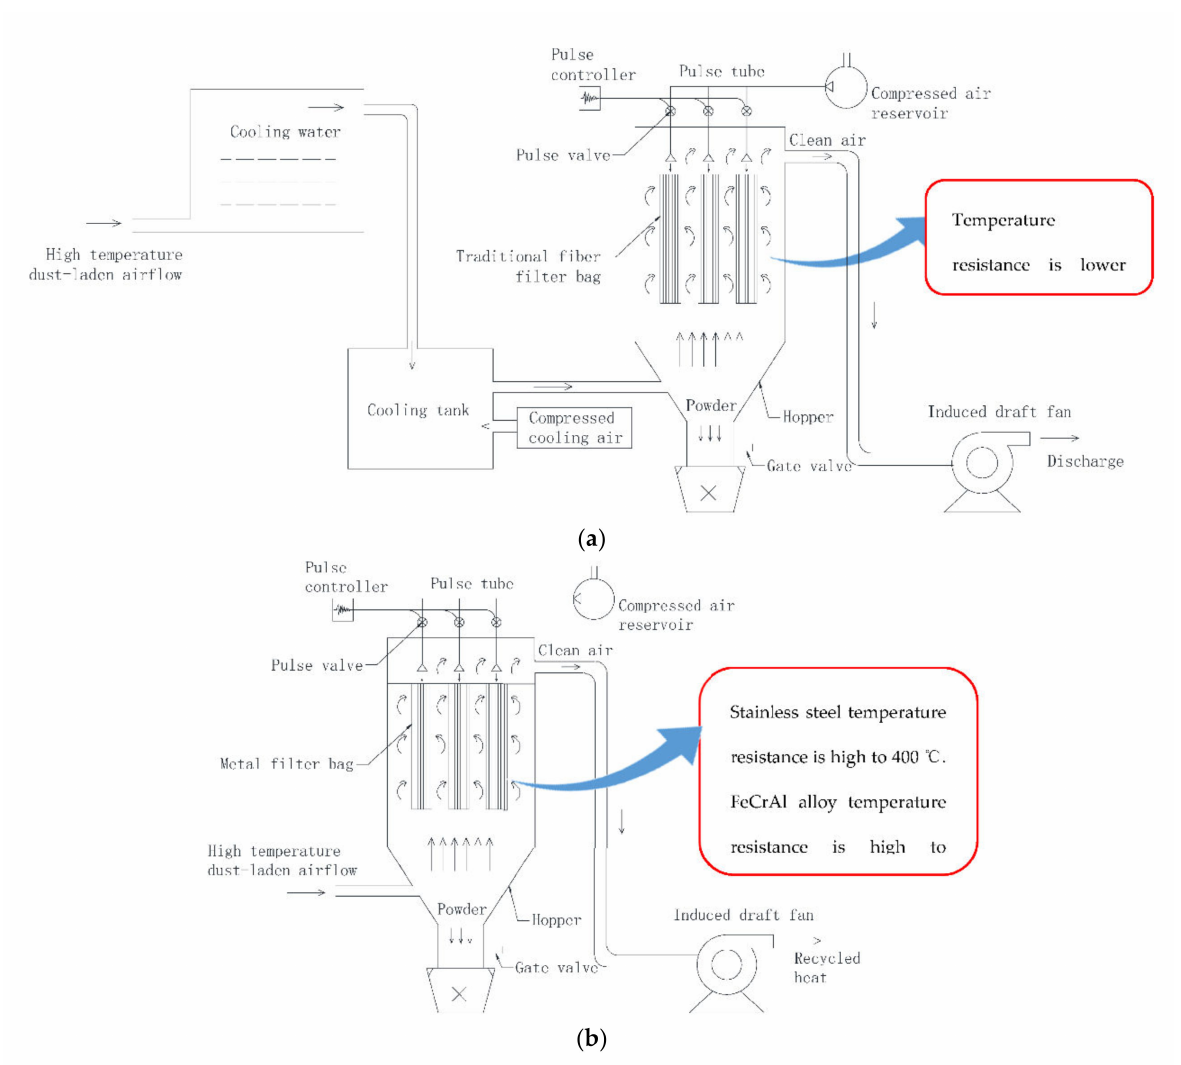
Figure 11. The traditional fiber filter bag and metal filter bag system for purifying the high- temperature dust-laden airflow. ( a ) The traditional fiber bag filter system for purifying the high- temperature dust-laden airflow. ( b ) The metal bag filter system for purifying the high-temperature dust-laden